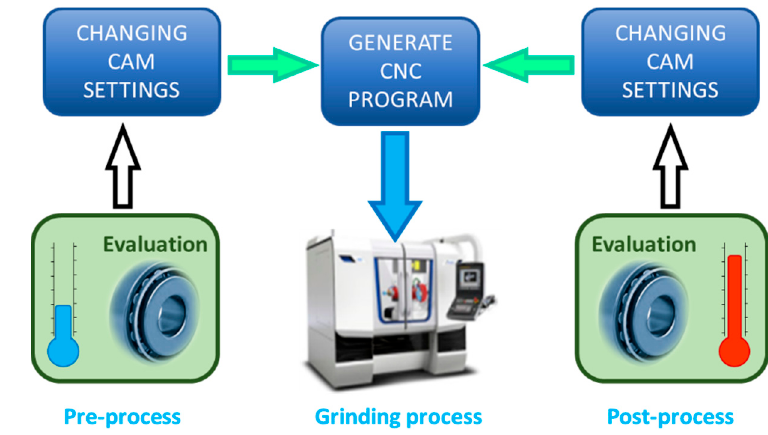
Figure 1. ( a ) Tapered roller bearing; ( b ) Functional dimensions; ( c ) Measurement device; ( d ) Synoptic of operation.